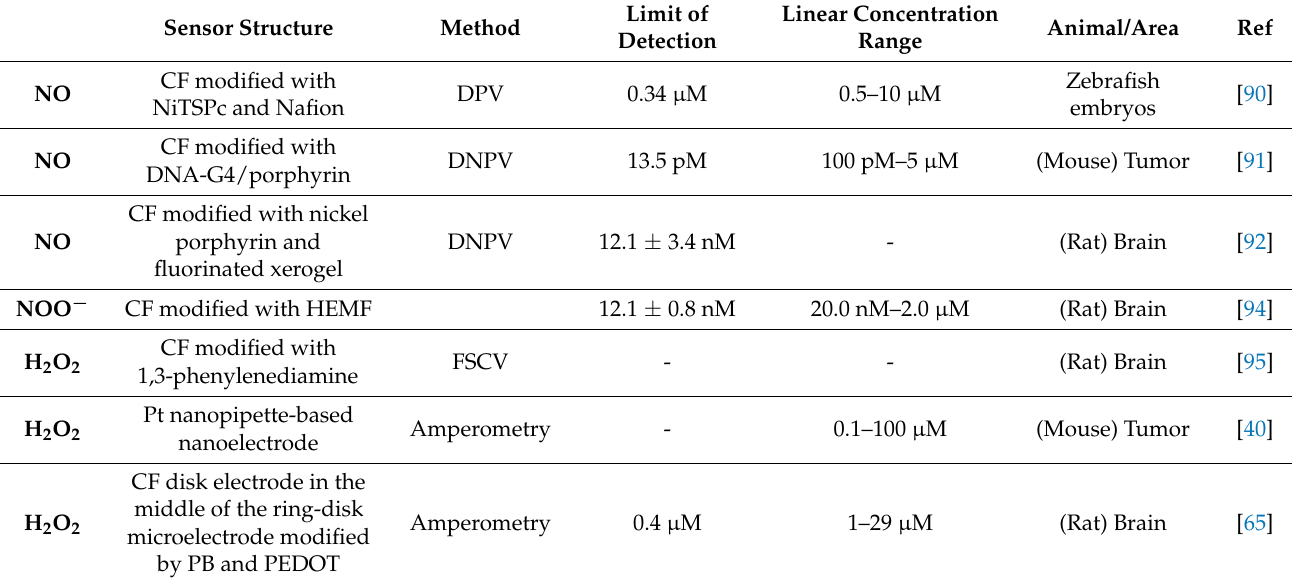
Table 2. Detection of ROS/ RNS in